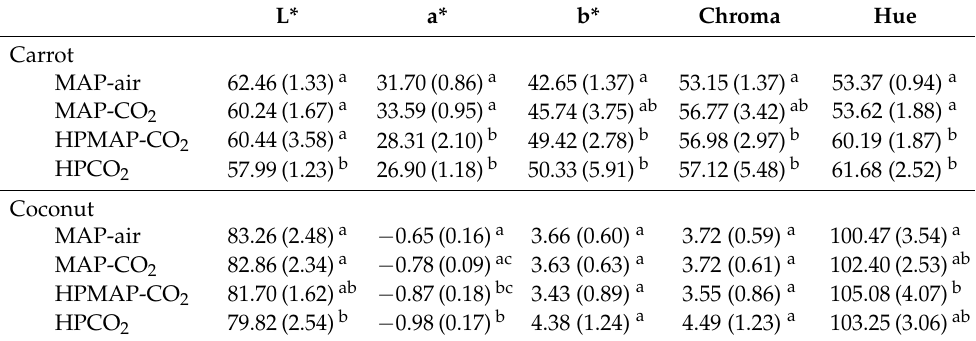
Table 2. Effect of the different treatments on the color of carrots and coconut, measured by CIELAB system, hue angle (H*), and chroma (C*). Treatment conditions were the same as detailed in Section 3.1. Values in brackets are SD. Means with different small superscript letters in the same column are significantly different ( p <